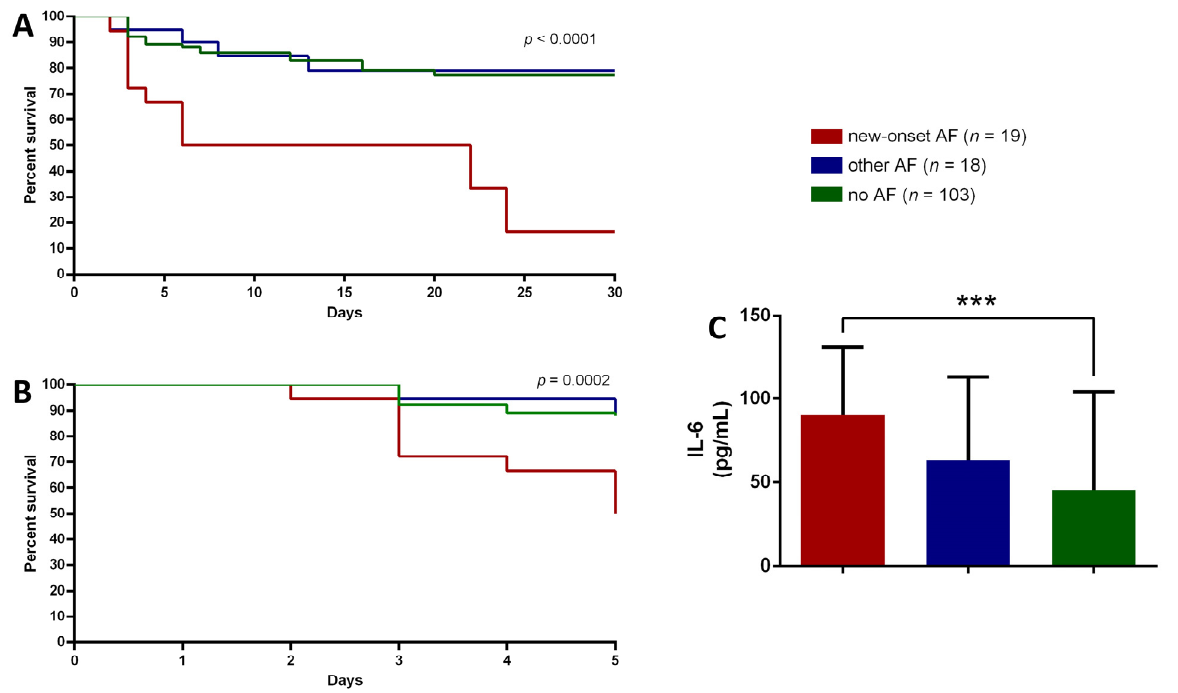
Figure 3. ( A – C ). Kaplan-Meier survival plot analysis for hospitalized COVID-19 patients, after the exclusion of participants with PaO 2 /FiO 2 > 300, with new-onset atrial fibrillation (new-onset AF, n = 19, red line), with other forms of AF (other AF, n = 18, blue line) and without AF (no AF, n = 103, green line) at 28 days ( A ) and at 5 days ( B ). Interleukin 6 (IL-6) serum levels comparison between study groups ( C ), after the exclusion of participants with PaO 2 /FiO 2 > 300. Data are expressed as median ± interquartile range . *** = p < 0.0005.